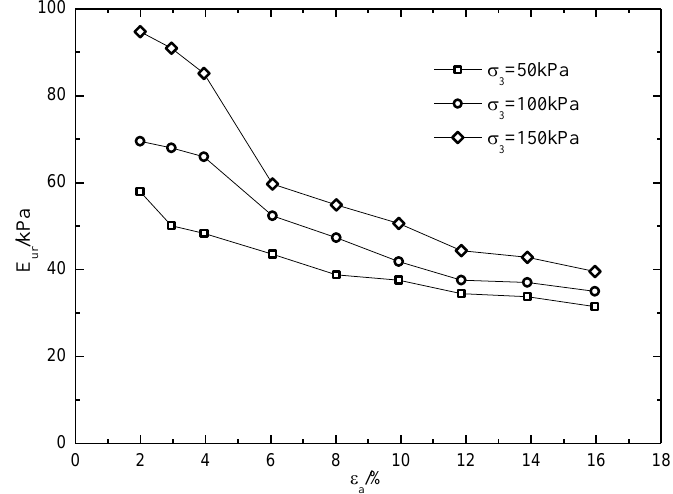
Figure 6. Resilient modulus versus axial total strain under different confining pressures.